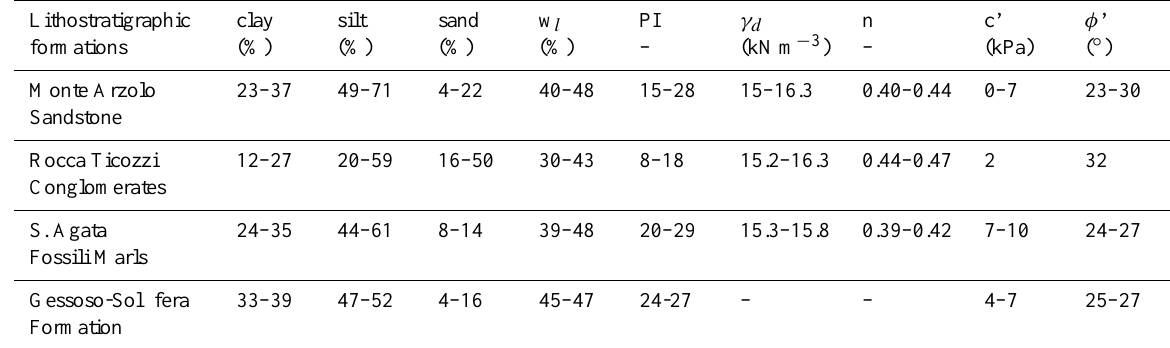
Table 1. Geotechnical characteristics of the colluvial soils involved in shallow landslides.